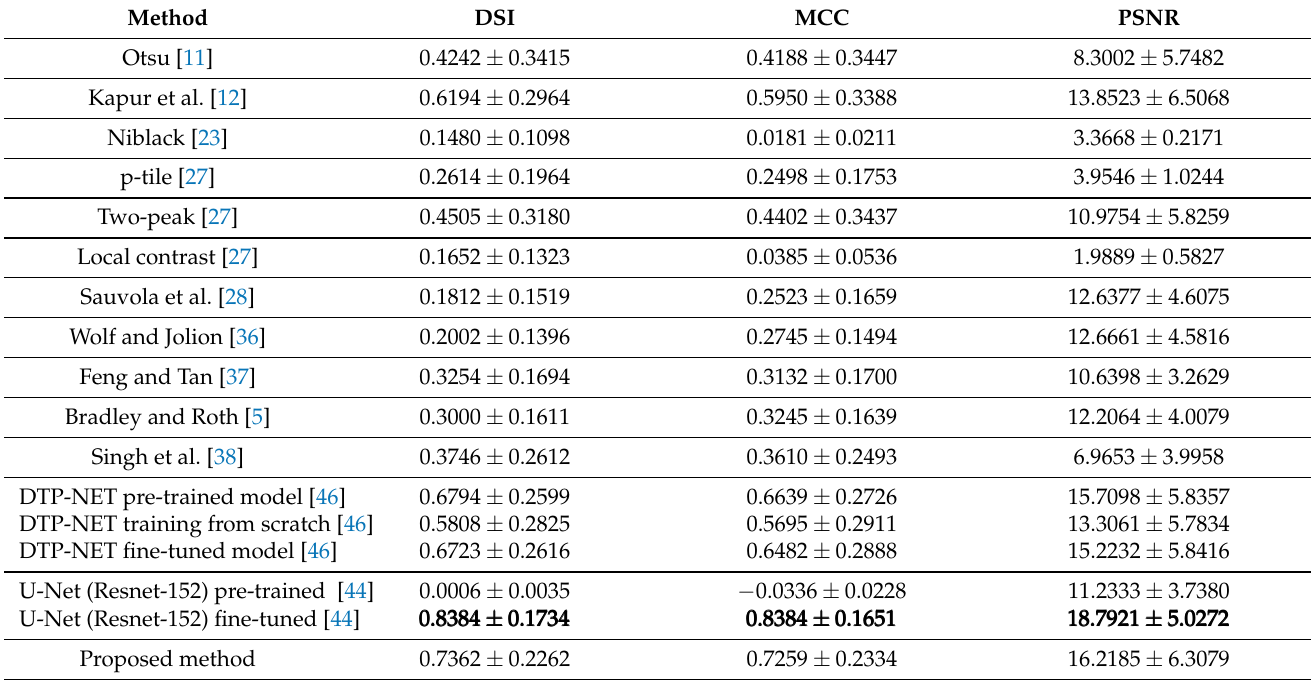
Table 1. DSI, MCC, and PSNR scores for the skin cancer dataset of 206 images used to test various thresholding techniques. The highest performance values are marked with bold